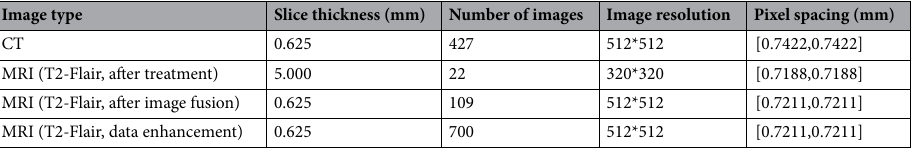
Table 1. The medical image specifications. CT computed tomography, MRI magnetic resonance imaging.